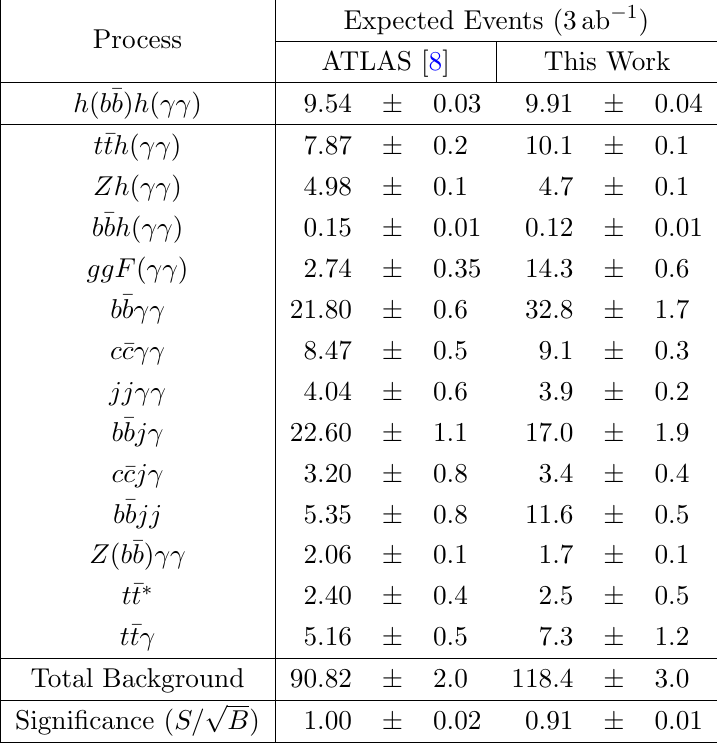
veto arises from muons in b -jets being erroneously labelled as isolated in the ATLAS